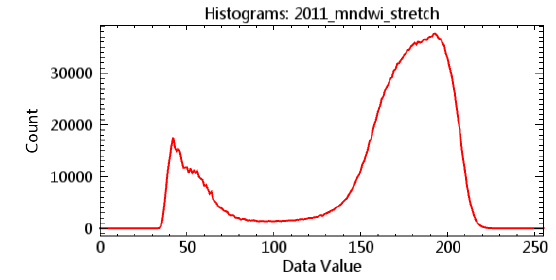
Figure 5. 2011 MNDWI image histogram.